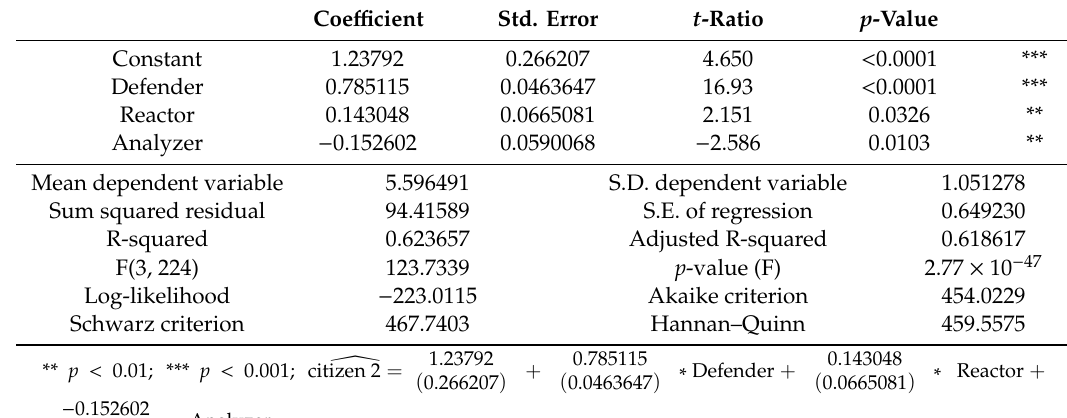
Table 2. Model 2: OLS, using observations 1–228. Dependent variable: Citizen